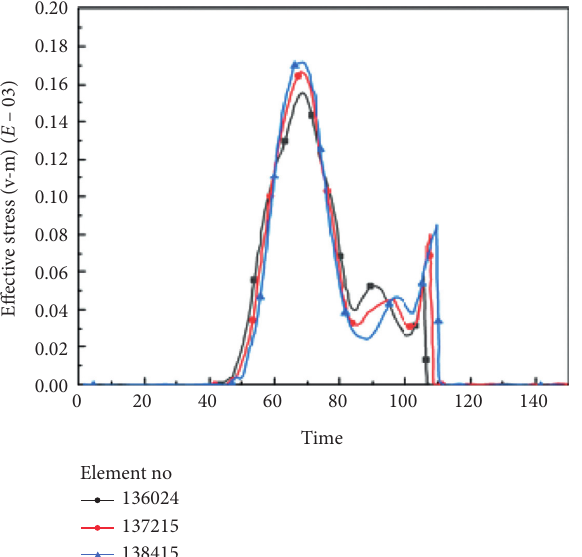
Figure 15: Curve of maximum principal stress on selected elements.